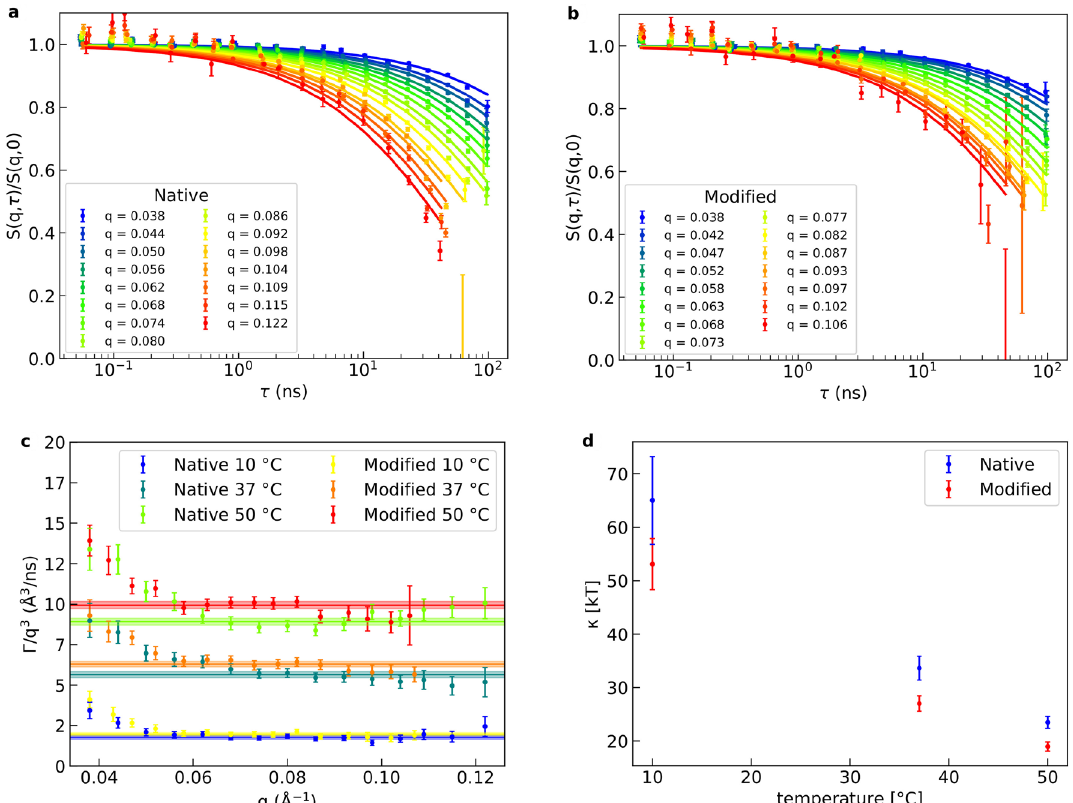
Figure 5. Dynamics of LUV bending fluctuations measured by NSE and determination of bending rigidity. ◦ NSE data of (a) native and (b) EAE modified liposomes at 50 C. The solid lines of the respective color show the respective fit with Zilman-Granek + center of mass diffusion model for each q -value. In (c) the fit parameter Ŵ/ q 3 is plotted against q and fitted with a constant for each temperature and composition. The fit is indicated as a solid line in the respective color and its standard error by the thickness of the slightly transparent enveloping 3 lines. In (d) the bending rigidity κ calculated of the Ŵ/ q fit values is plotted over the temperature for native and EAE modified lipid